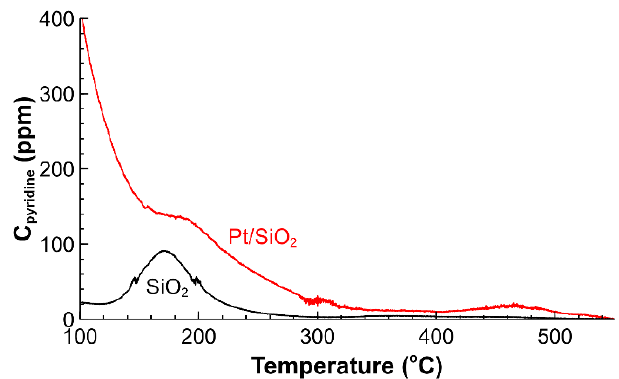
Figure 6. Temperature-programmed desorption profile of pyridine from the Pt/SiO 2 catalyst and SiO 2 support.